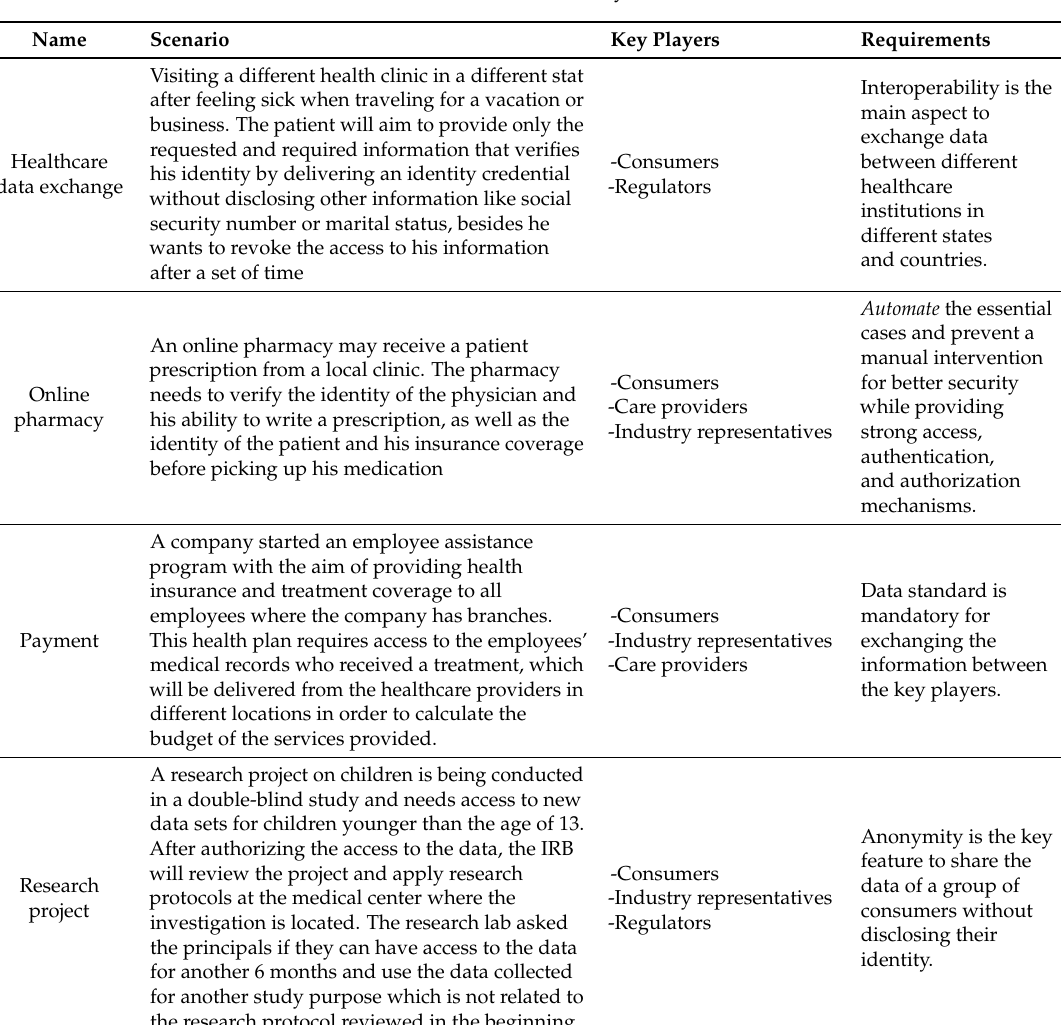
Table 4. The healthcare identity